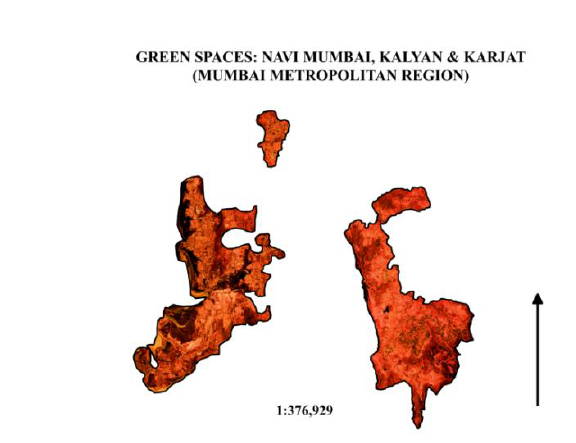
Figure 2 : Green Spaces: Navi Mumbai, Kalyan and Karjat Source : Landsat 8, May,2018